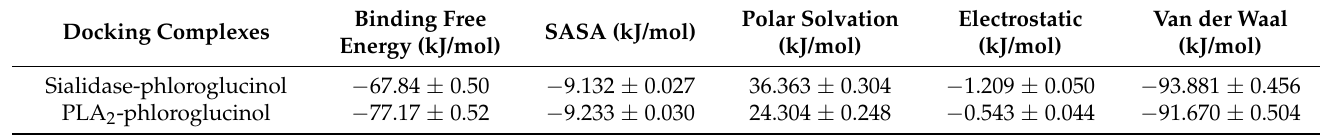
Table 2. MM-PBSA calculations of binding energy for phloroglucinol docked to sialidase and PLA 2 . Docking